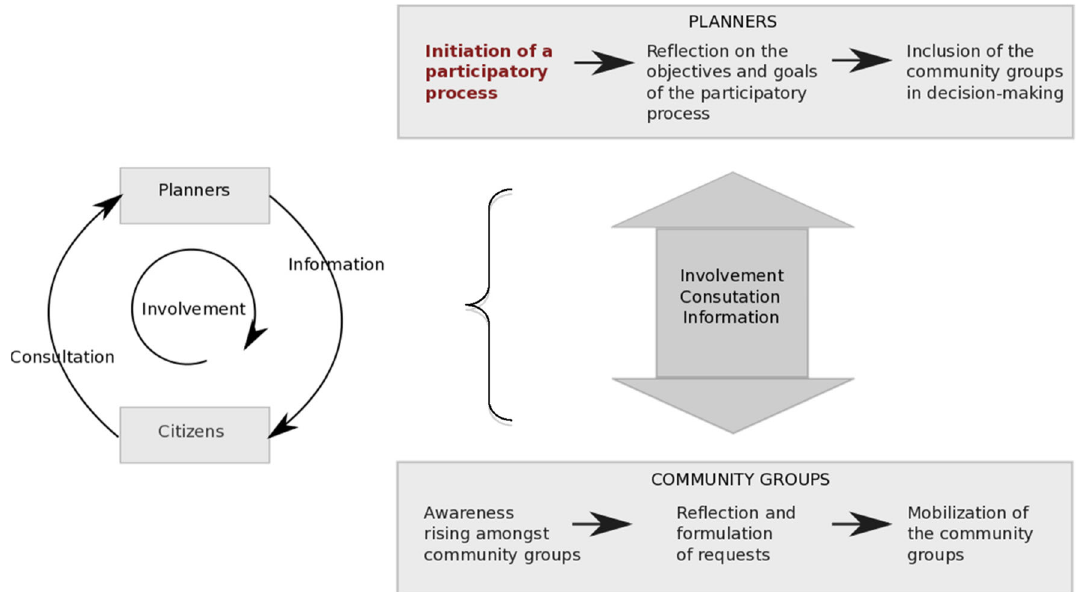
Fig. 4 Combined top-down and bottom-up process leading to greater involvement of the community groups. The initiation of the participatory process by the planners, in red, is perceived as the triggering element. The figure was created by the